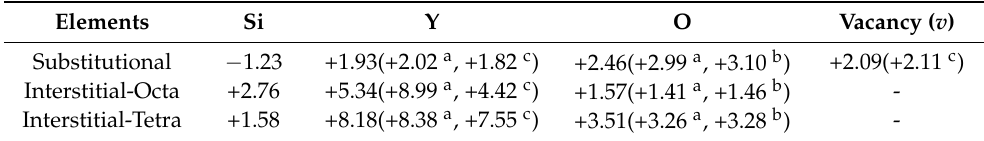
Table 2. Formation energies (eV) of Si, Y and O in different sites (substitution, octahedral interstice and tetrahedral interstice).